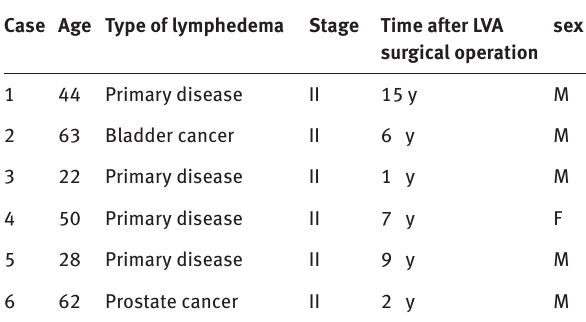
Table 1: Clinical background of the patients